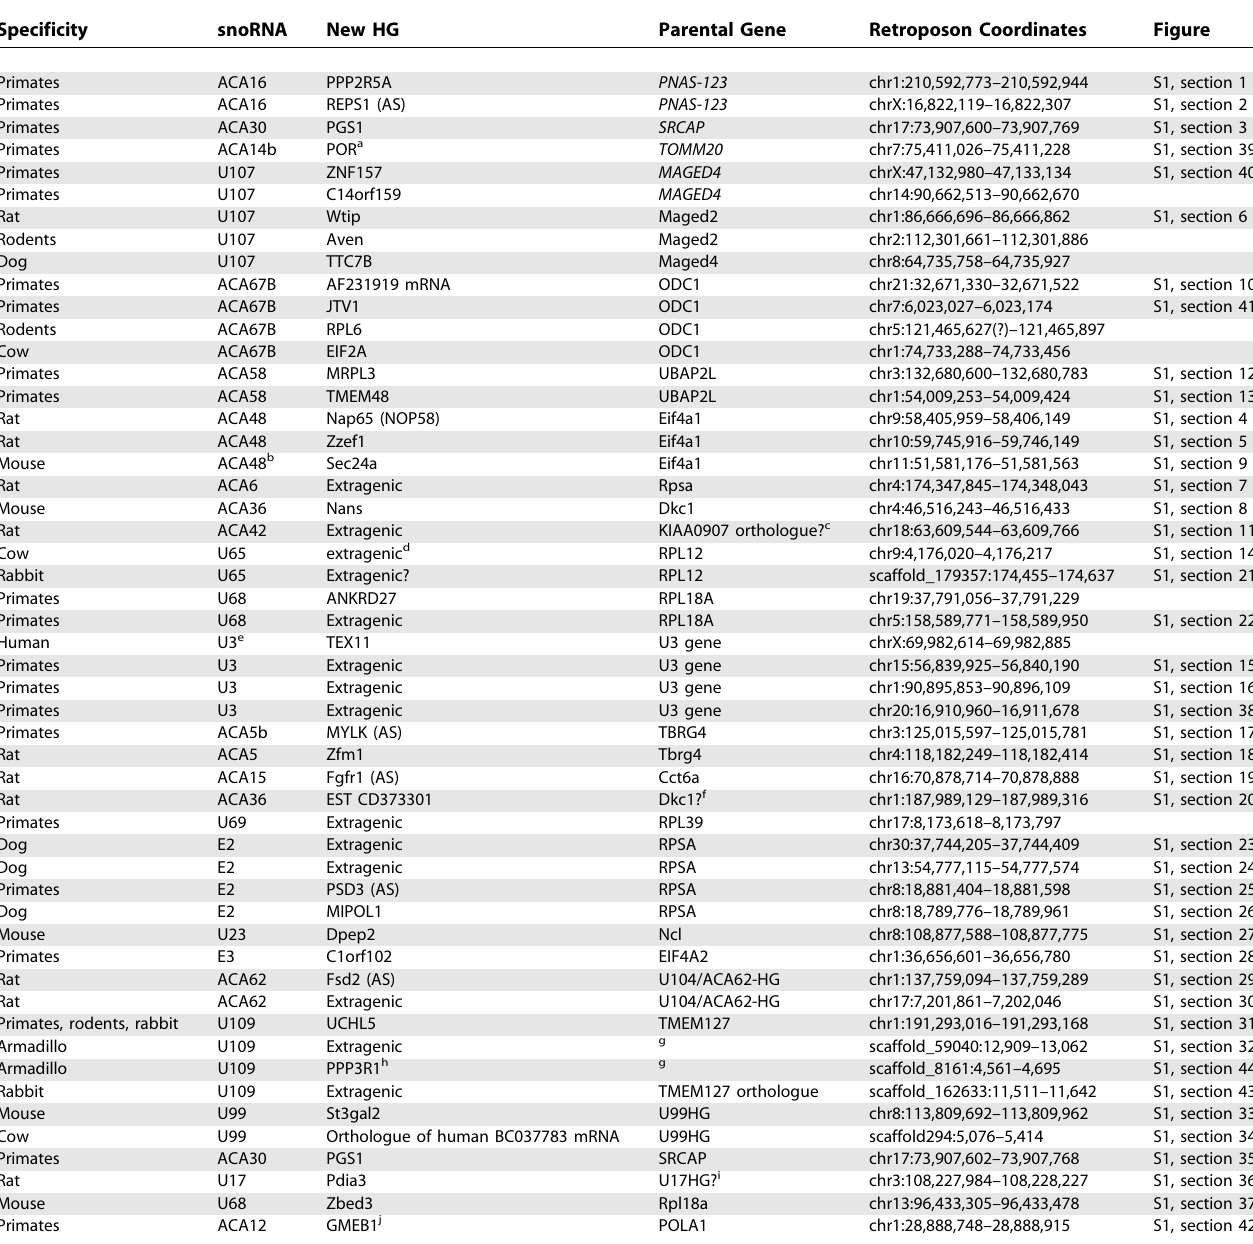
Table 1. Examples of Mammalian Type 1